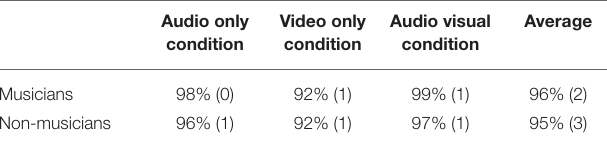
TABLE 2 | Musicians and non-musicians’ correct responses in percentage and standard deviations in parenthesis, in response to the target in AO, VO, and AV